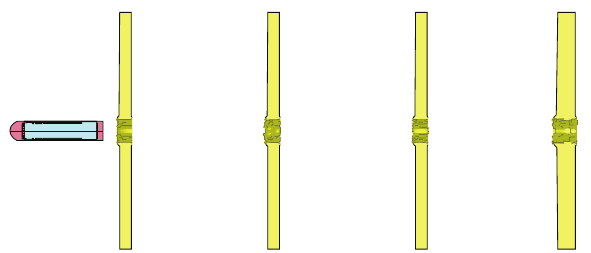
Figure 12: Simulation results of warhead penetrating into four-layer target ( V = 579 m/s).